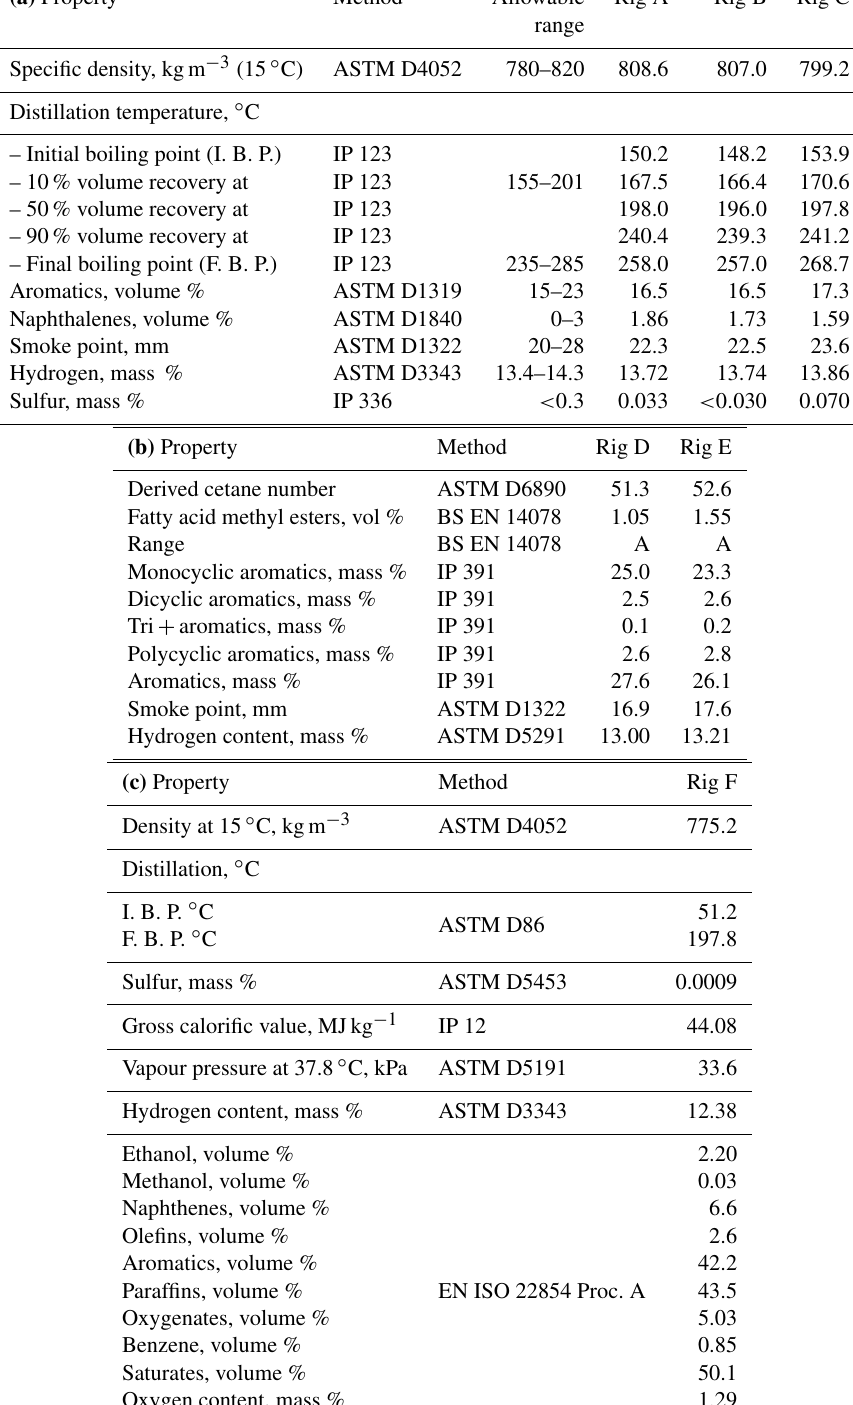
Table 2. (a) Physical and chemical properties for the Jet A-1 fuels (kerosene) used in Rigs A, B, and C. (b) Physical and chemical properties for the EN590 fuels (diesel) used in Rigs D and E. (c) Physical and chemical properties for the EN228 fuel (gasoline) used in Rig